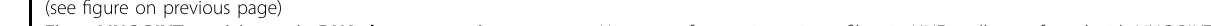
Fig. 4 LINC-PINT participates in DNA damage repair response. a Heatmap of transcriptomic pro fi ling in HNE1 cells transfected with LINC-PINT- expressing plasmid or control plasmid (green = downregulated; red = upregulated). b Gene ontology analysis of LINC-PINT-affected mRNA. The “ Response to stress ” network was among the top ten most differentially expressed. c , d IR-induced DNA damage in LINC-PINT-overexpressing cells and control group were analyzed by the comet assay at oh, 1, 2, 4, and 10 h. Representative images ( c scale bars, 50 µm) and quantitative analysis ( d ) of tail DNA in each group. e , f Representative fl uorescence images ( e scale bars, 20 µm; green, γ -H2AX; blue, DAPI) and quanti fi cation ( f ) of γ -H2AX foci in cells with and without LINC-PINT overexpression. H2AX foci were counted at 0, 1, and 4 h post irradiation. g The expression of different DNA damage response proteins in HNE1 and HONE1 cells, which were transfected with LINC-PINT-overexpressing plasmid or control plasmid with and without irradiation. The protein level was analyzed by western blot more than three times. GAPDH was used as a loading control. Data represent the mean ± SEM from three independent experiments ( c – g ). Statistical signi fi cance was calculated using a two-sided t test. * P < 0.05, ** P < 0.01, *** P <